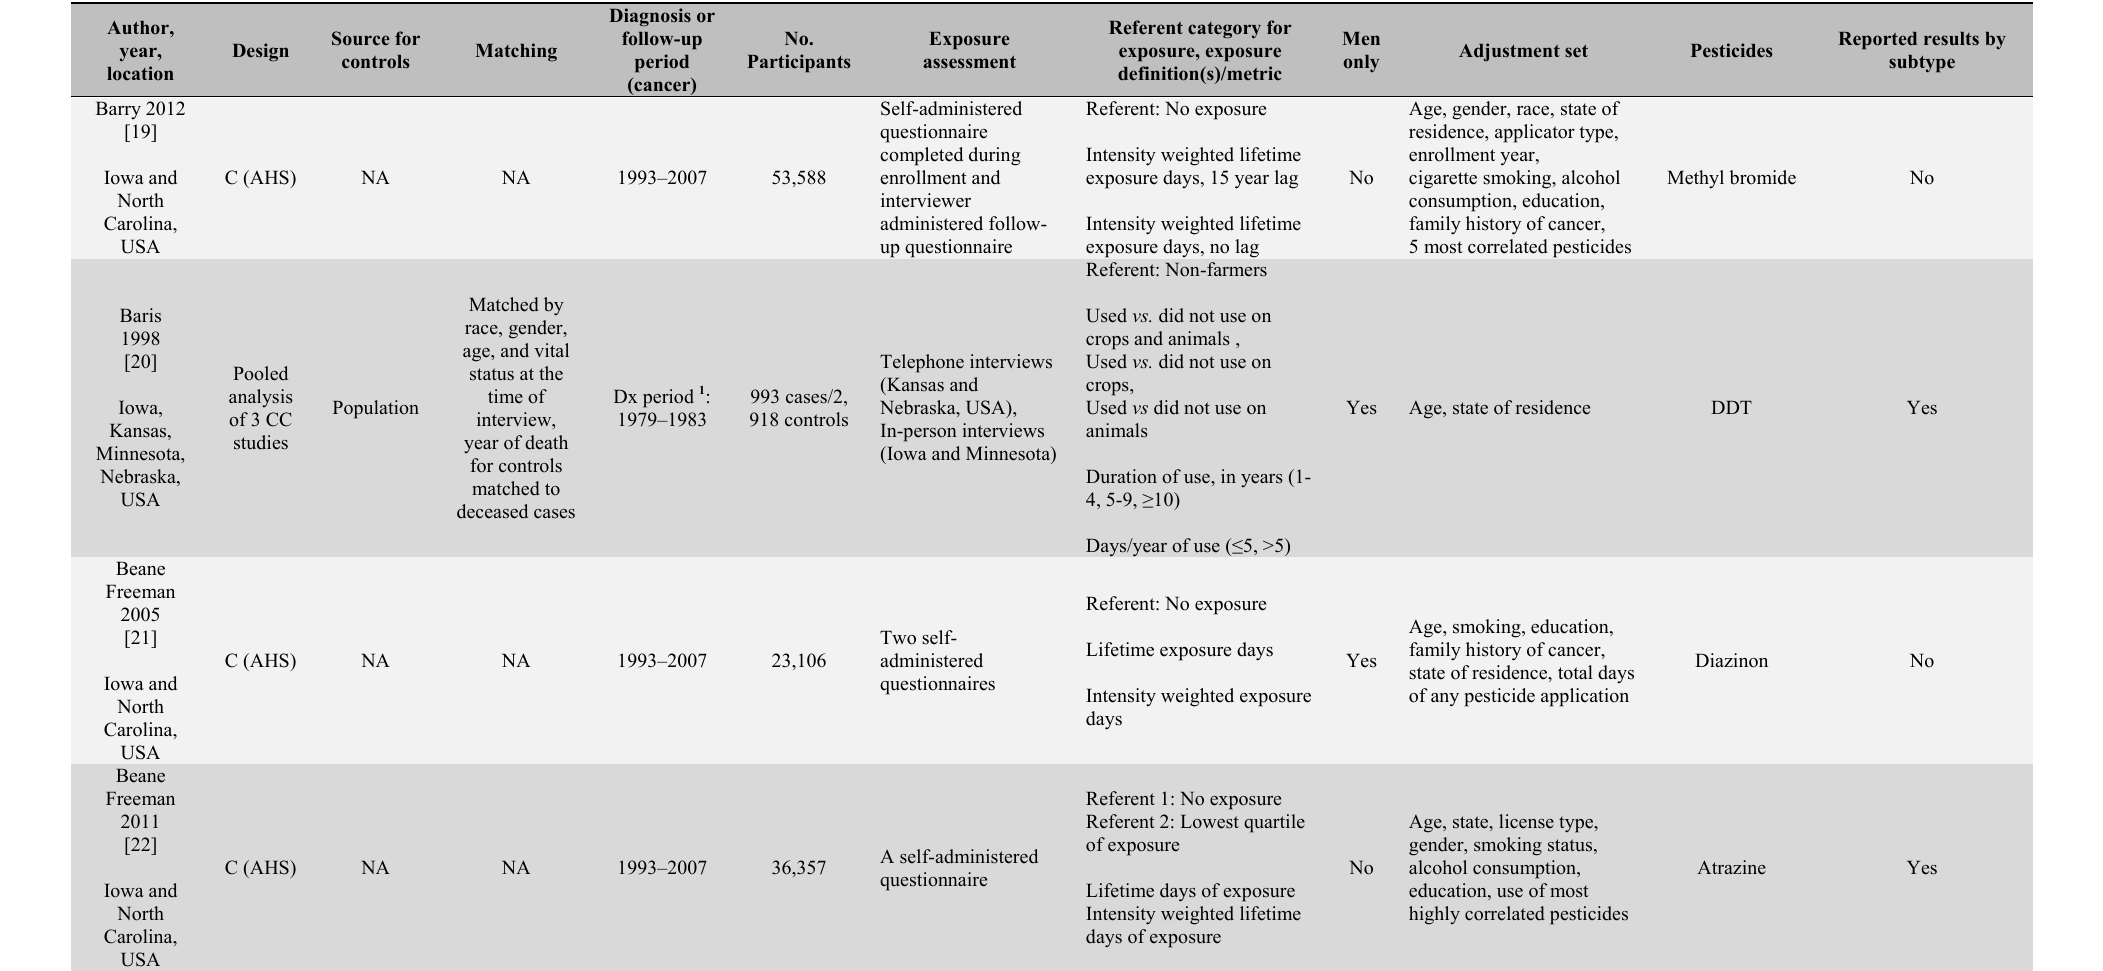
Table 1. Summary of papers from which effect estimates were